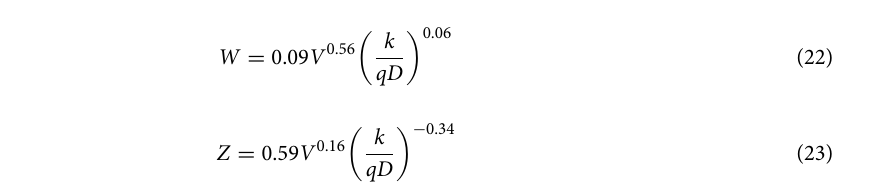
Figure 3. Relationship between ( a ) dimensionless wetted volume ( V ∗ ) and dimensionless wetted width ( W ∗ ) and ( b ) dimensionless wetted volume ( V* ) and dimensionless wetted depth ( Z ∗ ) for sandy